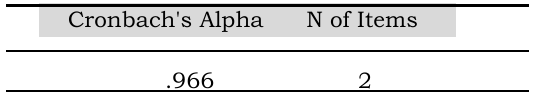
Table 1. Inter-rater Reliability of Try-out Class Correlation Reliability Statistics